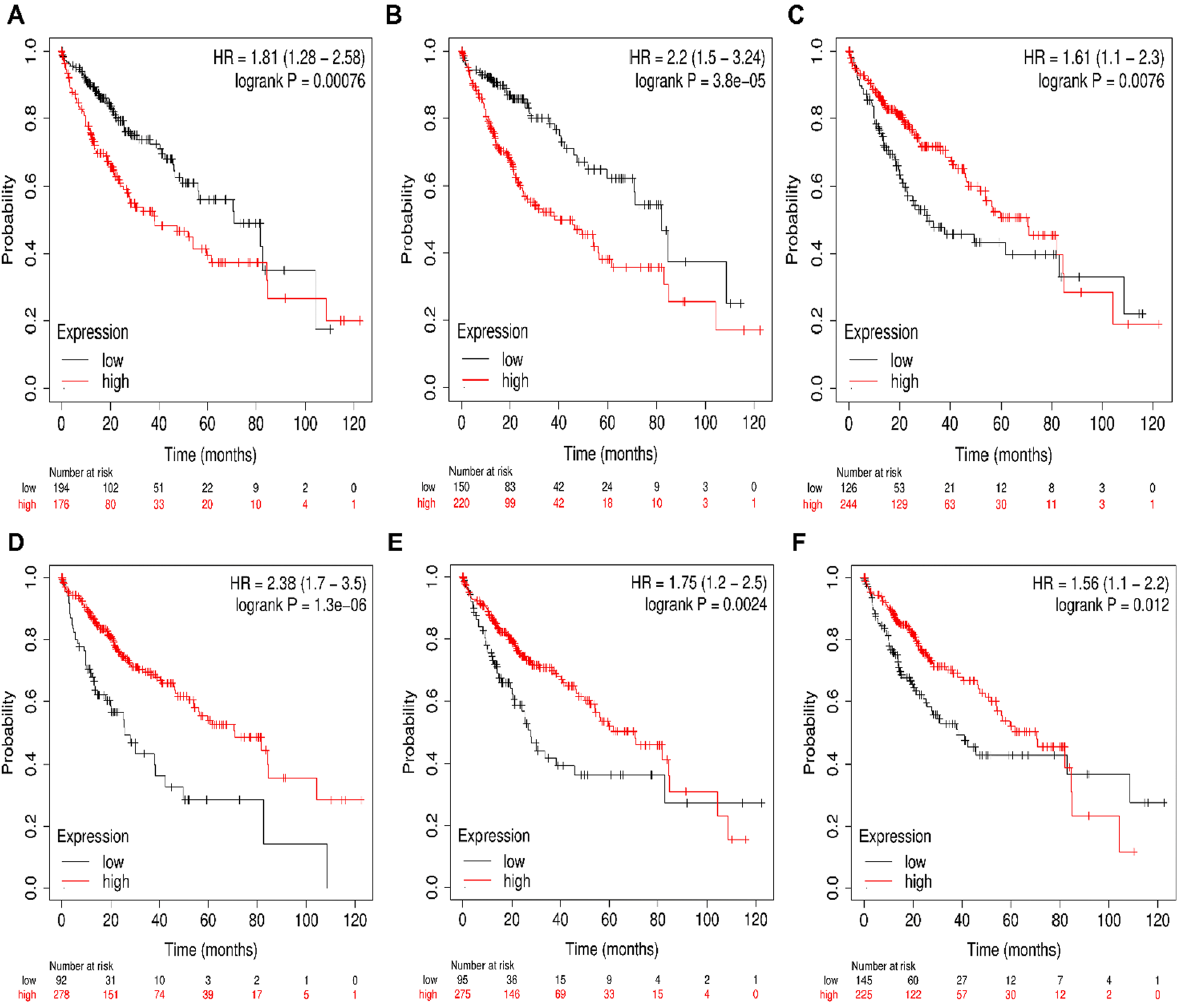
Fig. 2 KM plots showing the OS of A APLN, B E2F1, C ACADL, D ALDH2, E GADD45B, and F PCK1 across TCGA-HCC cohort. Higher and lower expression groups are signified by red and black